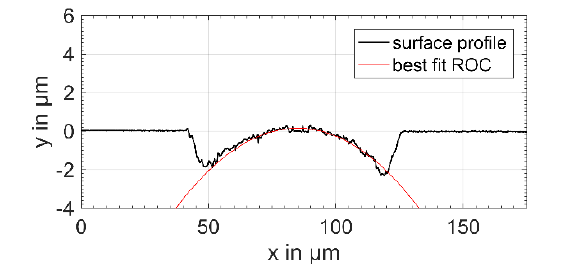
Fig. 3. Profile section of a cylindrical lens fabricated in calcium fluoride (H = 3.5 J/cm 2 , overlap 98 %).